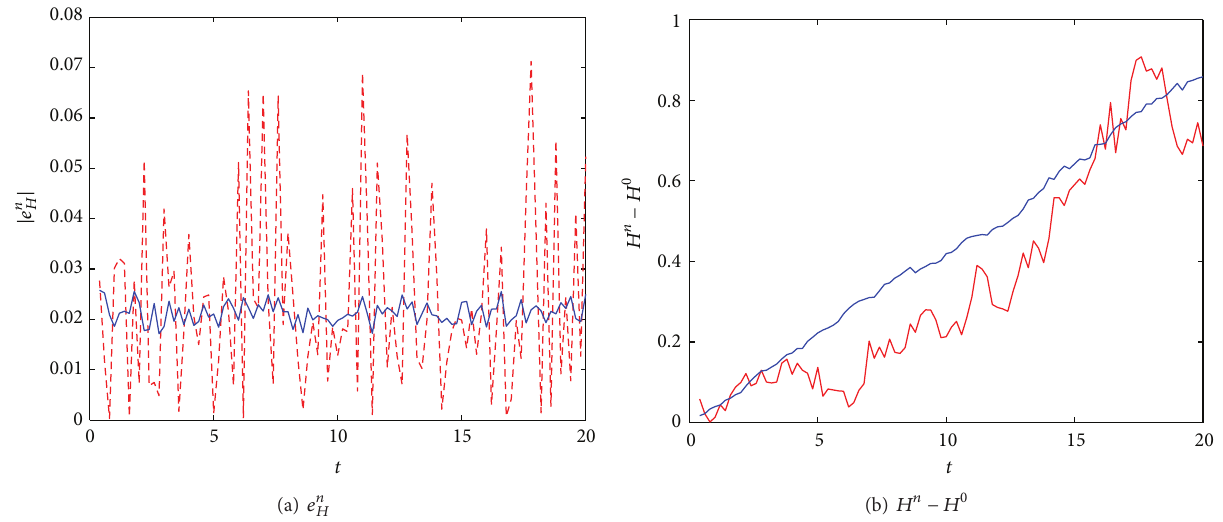
Figure 3: Residuals of discrete energy for one trajectory and the average energy over 50 trajectories.